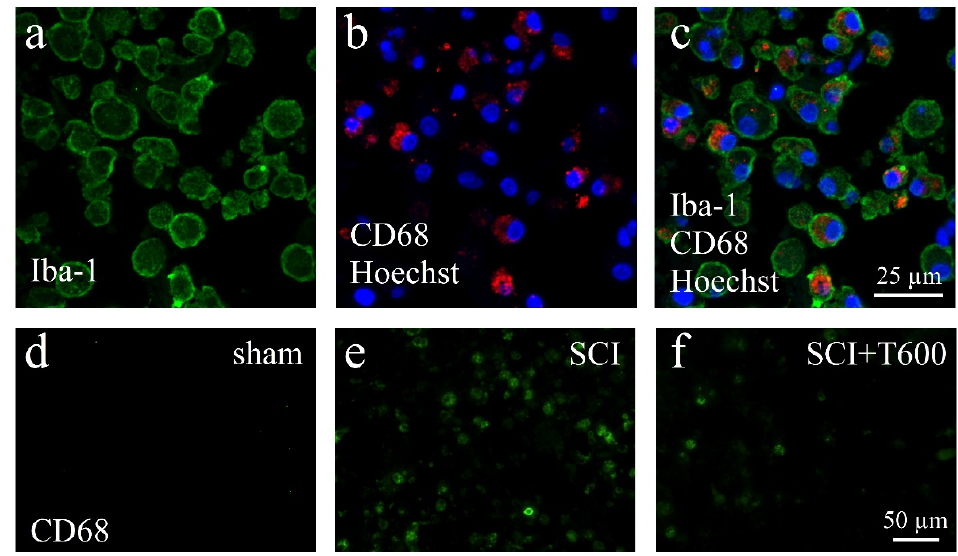
Figure 7. Activation of macrophages after SCI. ( a – c ) Confocal microscopy images show examples of macrophages in the SCI lesion center at 4 dpo. All cells are IR for Iba-1 ( a , green) and most also for CD68 ( b , red), shown in combination with nuclear staining ( b , c , Hoechst 33342, blue). ( d – f ) CD68 IR macrophages in the spinal cord after laminectomy ( d , sham), SCI ( e ), and SCI 2 × 300 mg/kg TUDCA treatment ( f ). Same magnifications are used in ( a – c ) and in ( d – f ) (scale bars in ( c , f )).